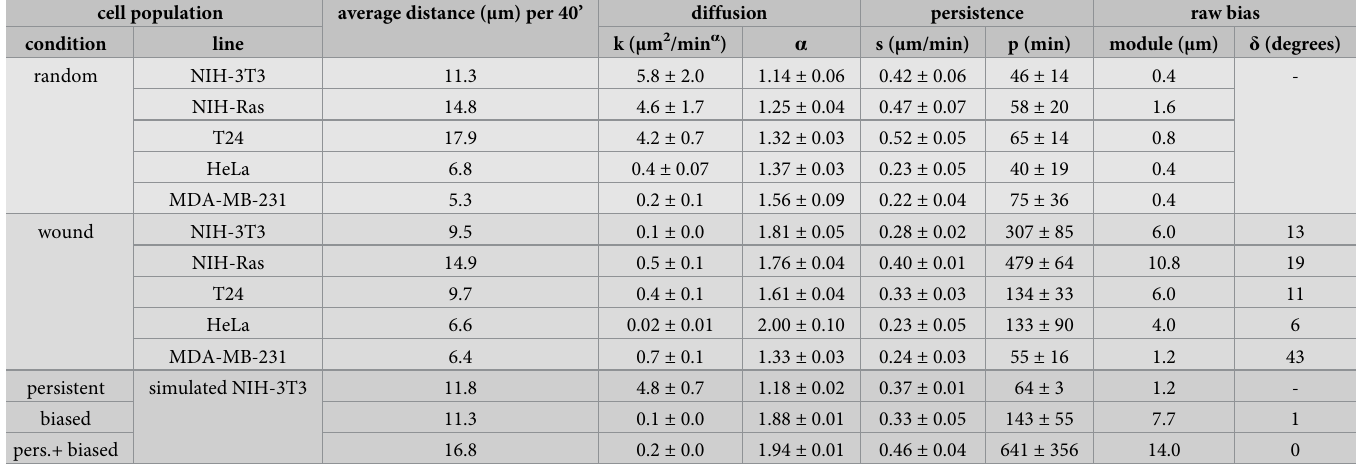
Table 1. Superdiffusion of different cell lines in different culture conditions. cell